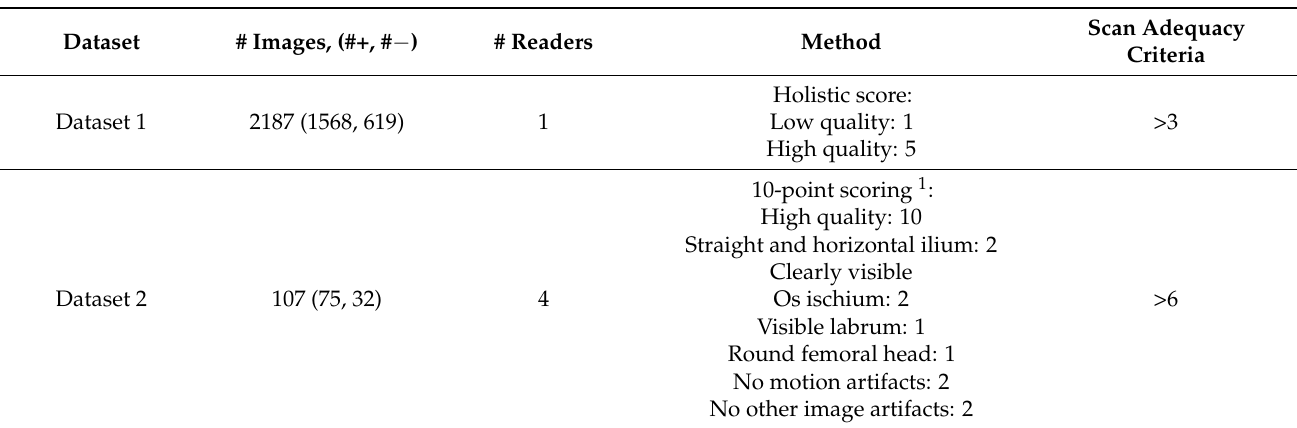
Table 1. Method of scoring used to evaluate Datasets 1 and Dataset 2. #+, # − indicate the number of adequate-quality and inadequate-quality images in each